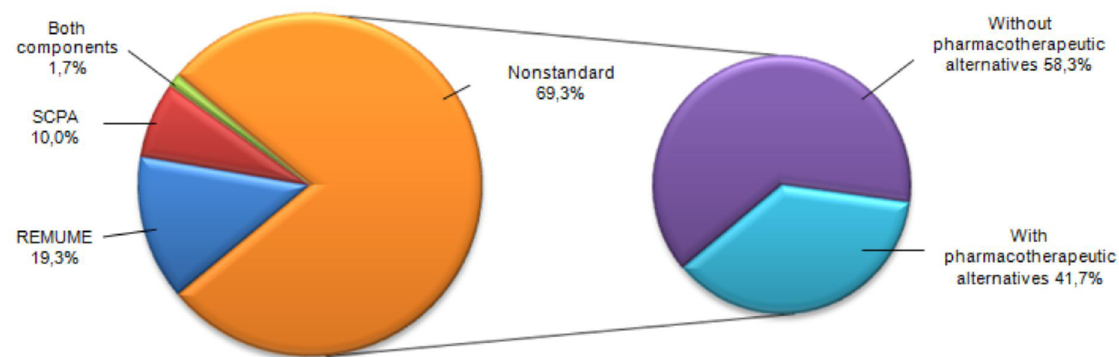
FIGURE 2 - Distribution of requested drugs in official lists for public access and existence of therapeutic alternatives. SCPA: Specialized Component of Pharmaceutical Assistance; REMUME: Municipal List of Essential